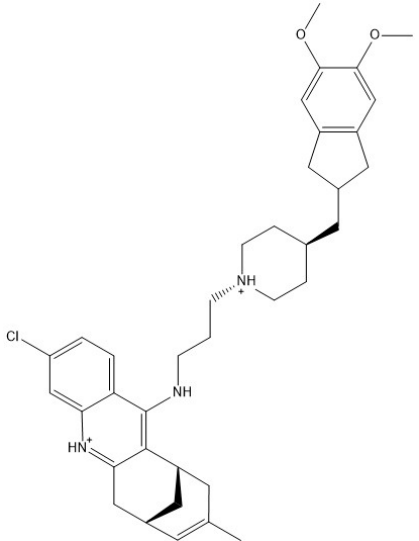
Figure 1. Structural formula of AVCRI104P4.